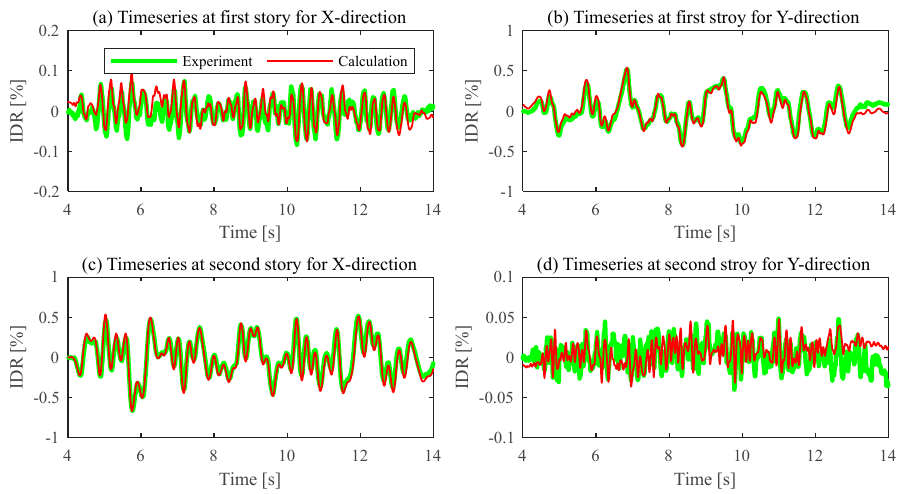
Figure 9. Comparison of interstory drift ratios (IDRs) estimated using accelerations measured by reference accelerometers and smartphones along the X and Y directions in test 3.